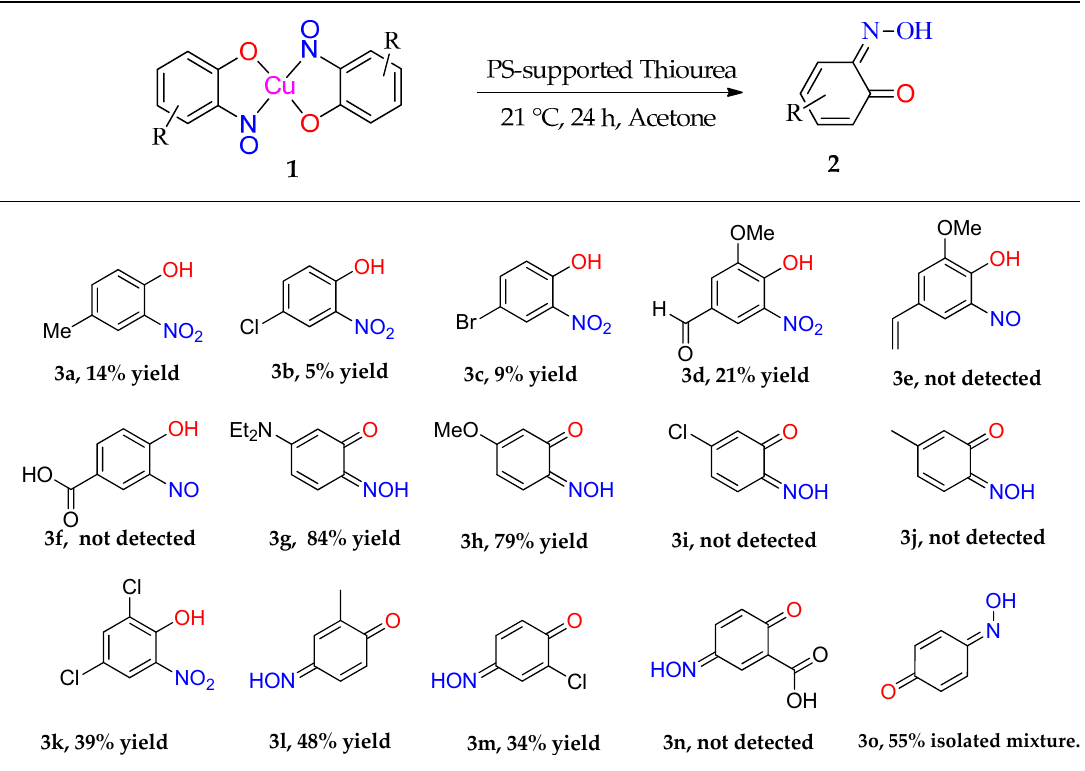
Table 2. Organic ligand isolation from copper(nitrosophenolato) compounds.